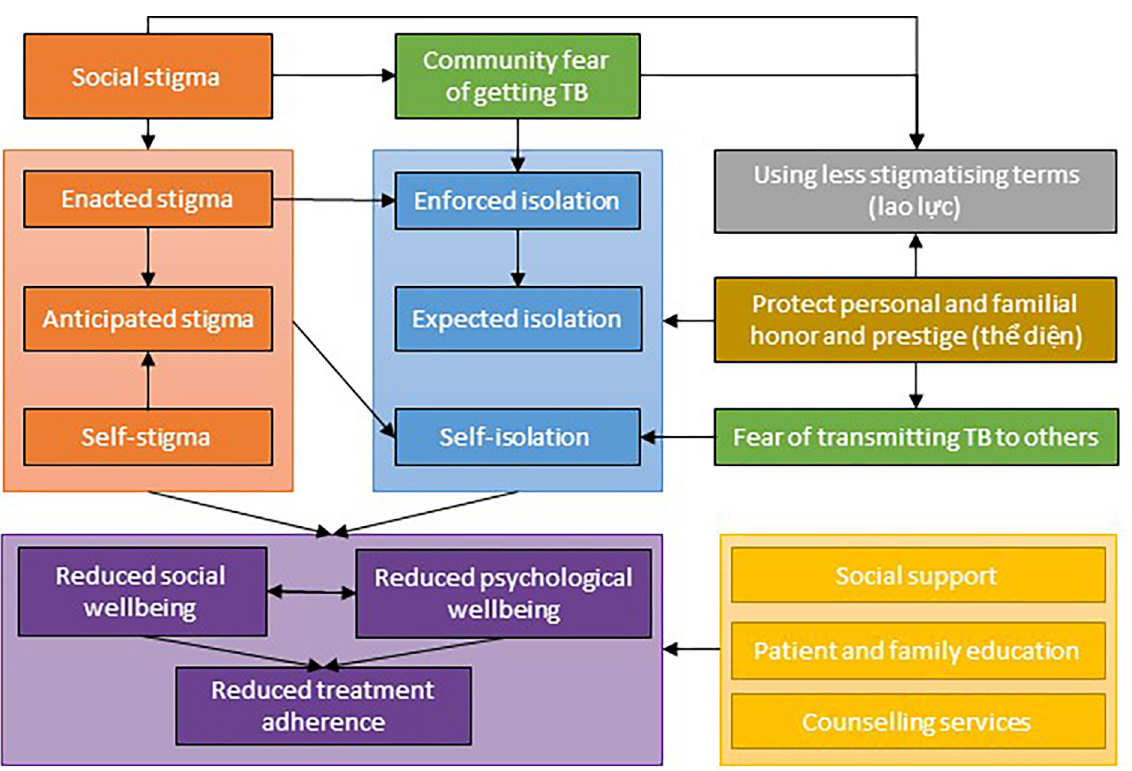
Fig 1. The drivers and consequences of stigma and isolation in people with DR-TB in Vietnam. DR-TB = drug resistant tuberculosis. Legend: Orange = types of stigma, blue = types of isolation, green = fears, purple = consequences of stigma and isolation, yellow = mediating